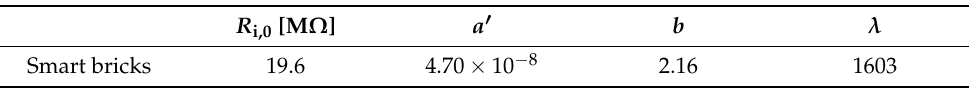
Table 1. Parameters used to specialize Equation (1) to retrieve strain measurements from the smart bricks embedded within the tested masonry wall specimens: R i,0 represents the unstrained internal electrical resistance of the smart bricks, a (cid:48) is the relative sensing at the contact interfaces between the surfaces of the sensors and their electrodes, b represents a positive constant referring to the contact resistance, and λ is the gauge